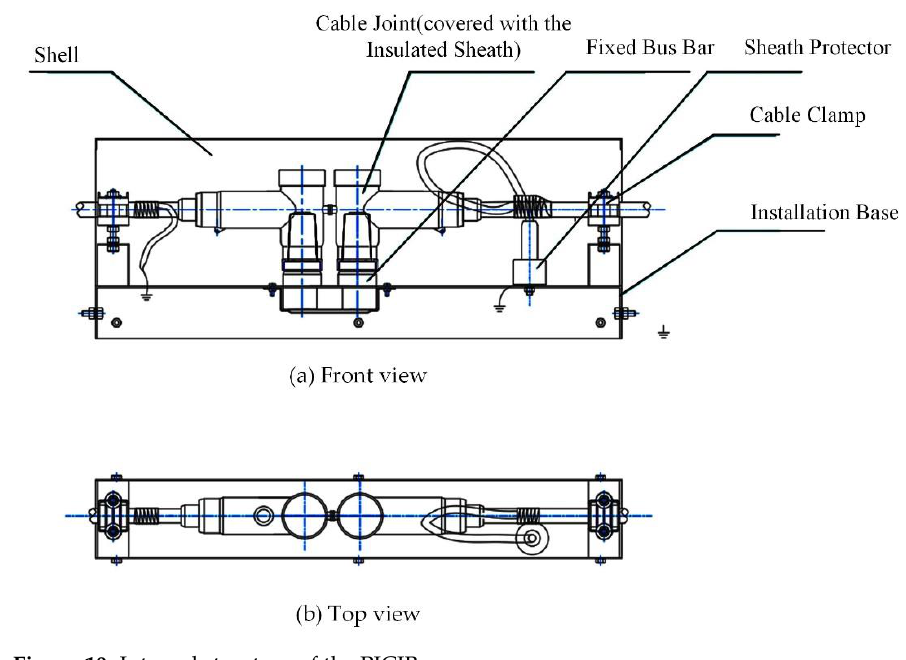
Figure 10. Internal structure of the PICJB.